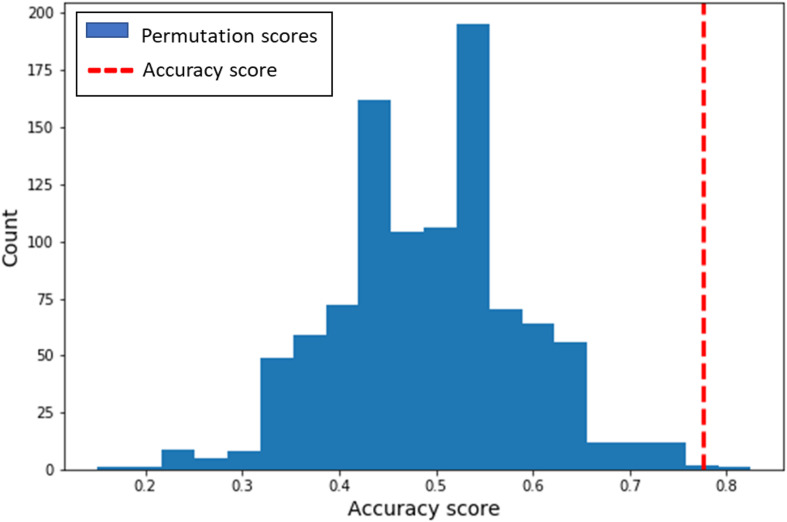
Distribution of classification performance. The blue bars indicate the predictions from the permutation test (N = 1000). The red dashed line represents the empirical accuracy score of the model (78%).